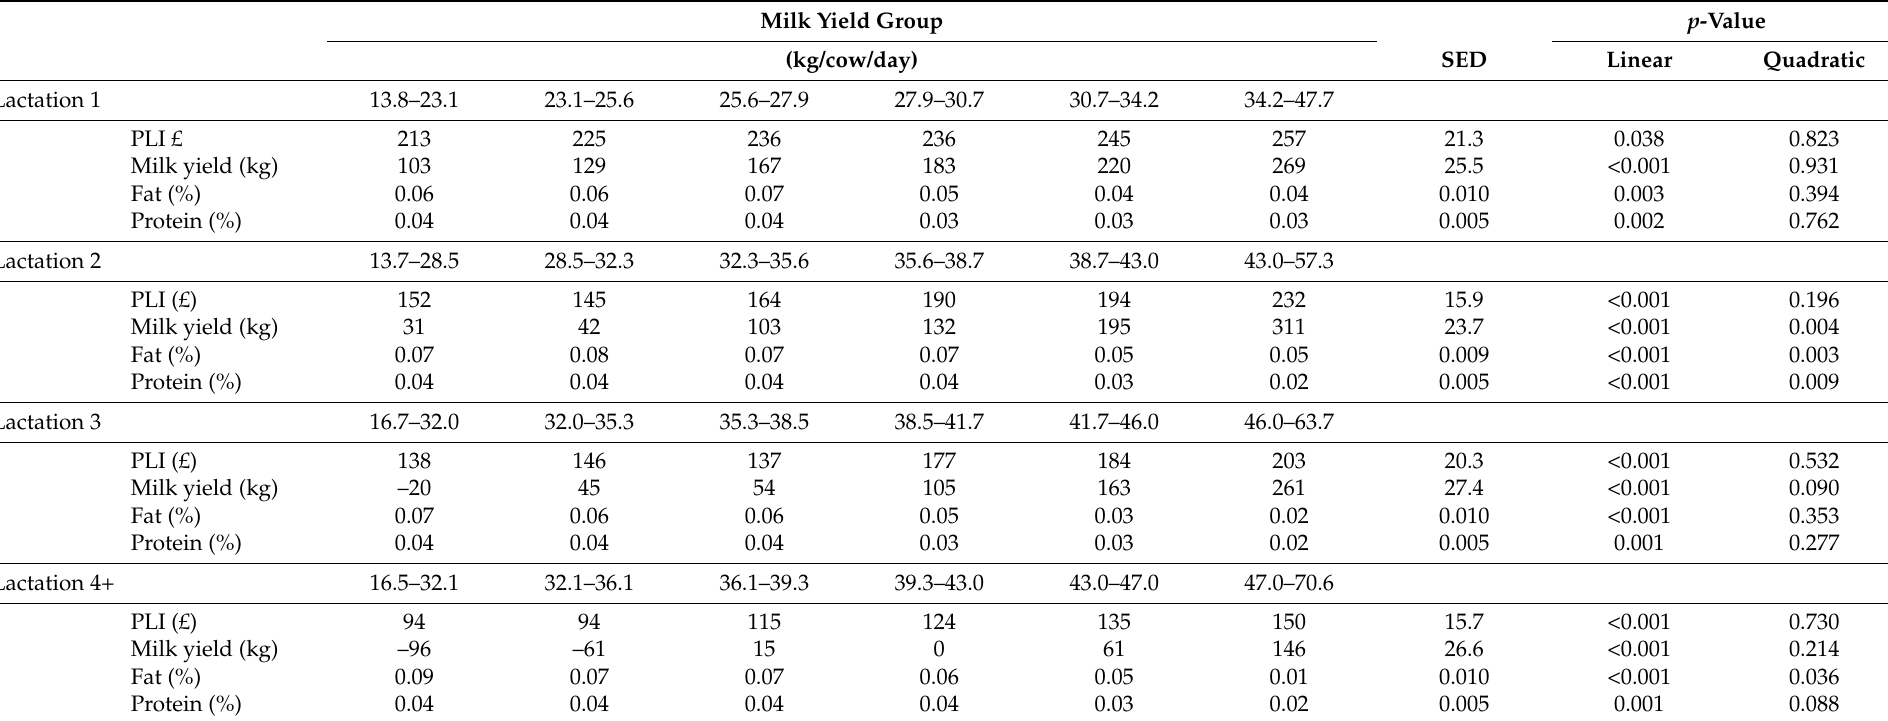
Table 6. Profitable Lifetime Index (PLI) and Predicted Transmitting Ability (PTA) for milk yield, milk fat percent and milk protein percent of experimental cows within each milk yield group, within each of lactations 1, 2, 3 and 4+. Milk Yield Group p